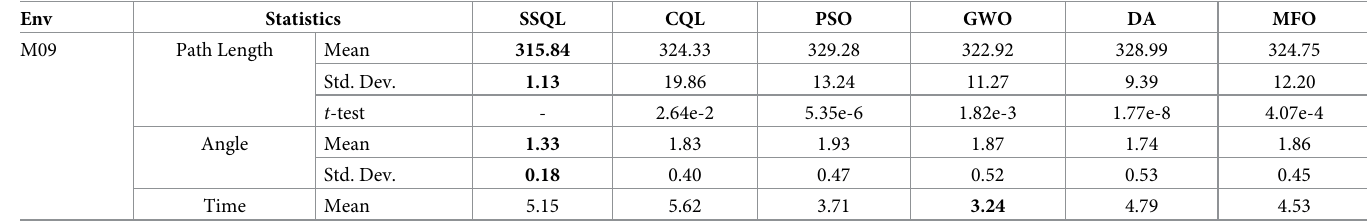
PLOS ONE | https://doi.org/10.1371/journal.pone.0275100 September 26,